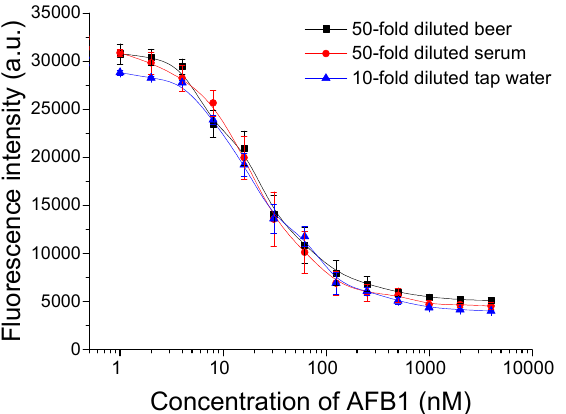
Figure 5. Fluorescence intensities corresponding to various concentrations of AFB1 spiked in 50-fold diluted beer, 50-fold diluted serum and 10-fold diluted tap water, respectively.